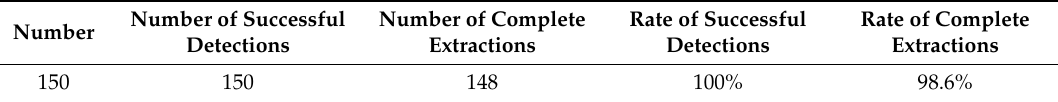
Table 4. The results for random